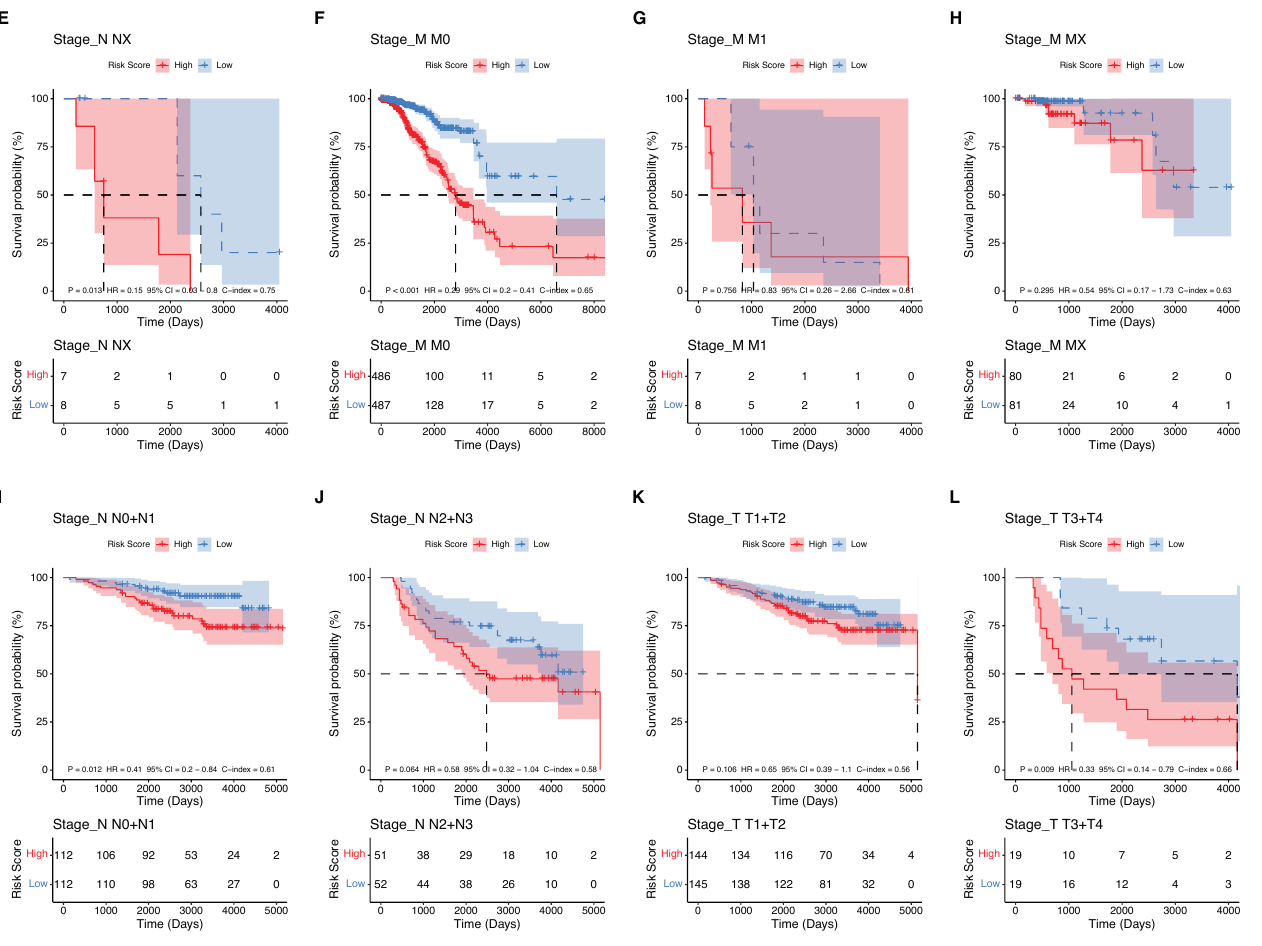
Figure 12. Predictive efficacy analysis of the signature. The results showed that the nomogram had high precision in the calibration analysis. In the training (Figure 13A) and validation (Figure 13F) cohorts, the nomograms showed the strongest survival predictor compared with the other clinicopathological features (Figure 13B,G).